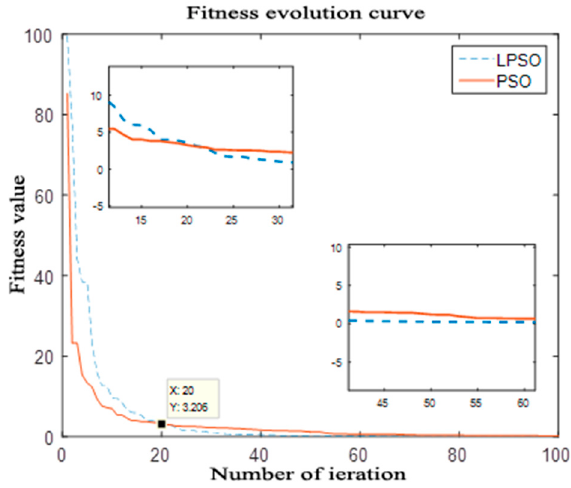
Figure 18. The fitness curve of the Sphere function.